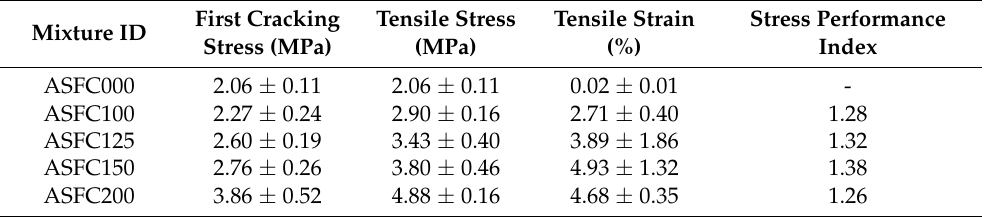
Table 6. Direct uniaxial tensile test